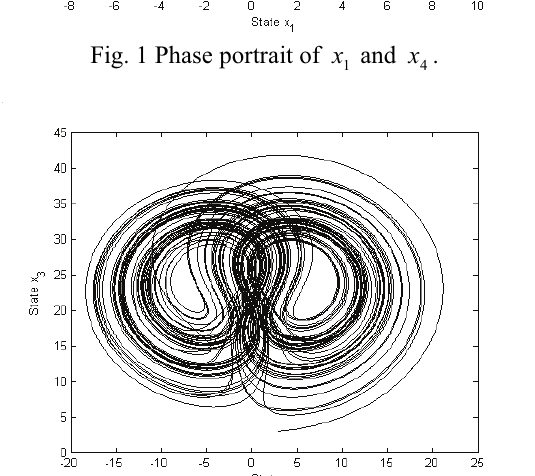
Fig. 2 Phase portrait of